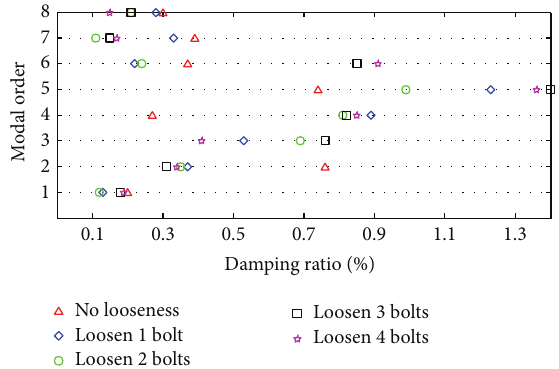
Figure 12: Scattergram of damping ratios of TCS under BLB with different looseness